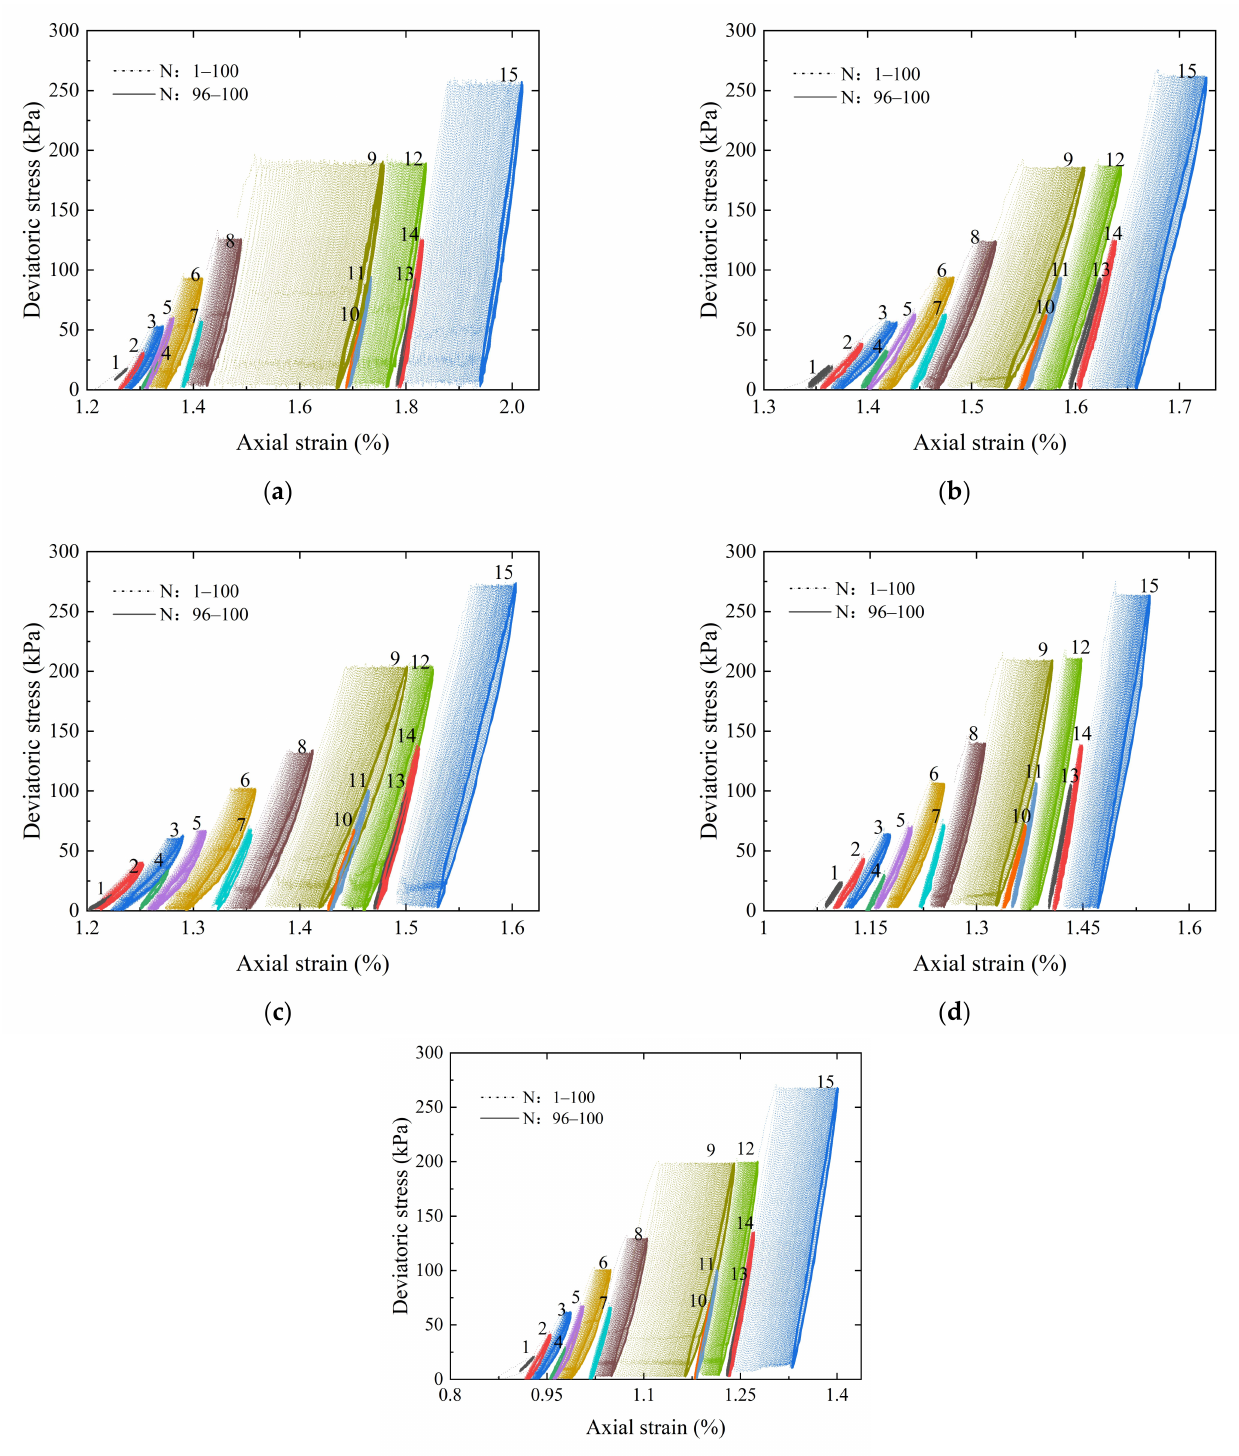
Figure 11. Hysteresis curves of the deviator stress versus axial strain of recycled BDW aggregates with different gradations: ( a ) G/S = 1.0; ( b ) G/S = 1.6; ( c ) G/S = 1.8; ( d ) G/S = 2.0; and ( e ) G/S =